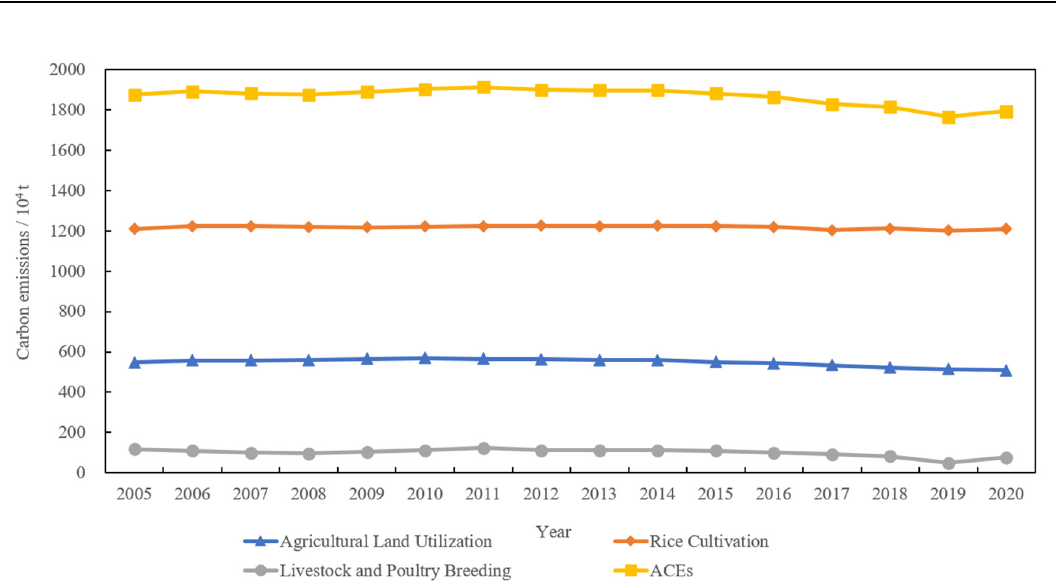
Figure 2. Trends of ACEs in Jiangsu Province, China, 2005–2020.